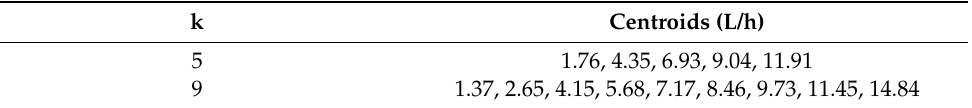
Figure 9. Driving recommendation timeline for the studied trip respecting Table 3′s seven rules. Finally, as an example of the logical link between quantitative FC estimation (based on RF) and FL reasoning, we can consider the FC peak at sample number 140 in Figure 6. The actual values, reported in Table 6, show the triggering of the instant driving recom- mendation number 7. In particular, according to the FL membership functions, RPM is very high (VH) and TPS is high (H), and the estimated consumption of fuel is VH, which triggers the rule 7 message: “Shift up the gear”. Table 6. Driving feedback for a sample of the studied track (H: high, VH: very high) . Event Detector